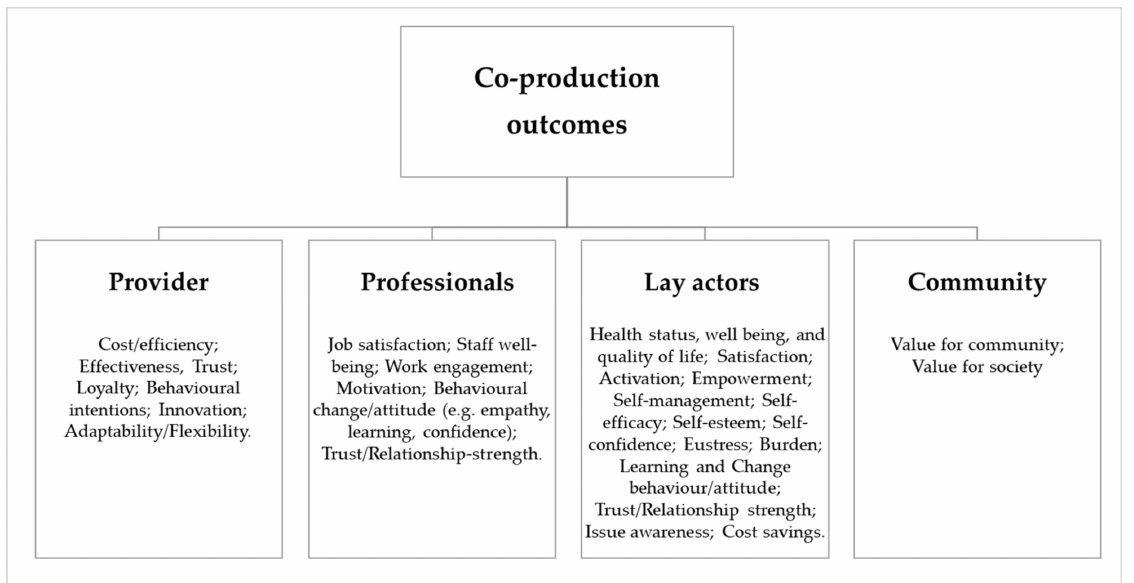
Figure 4. Analytical components